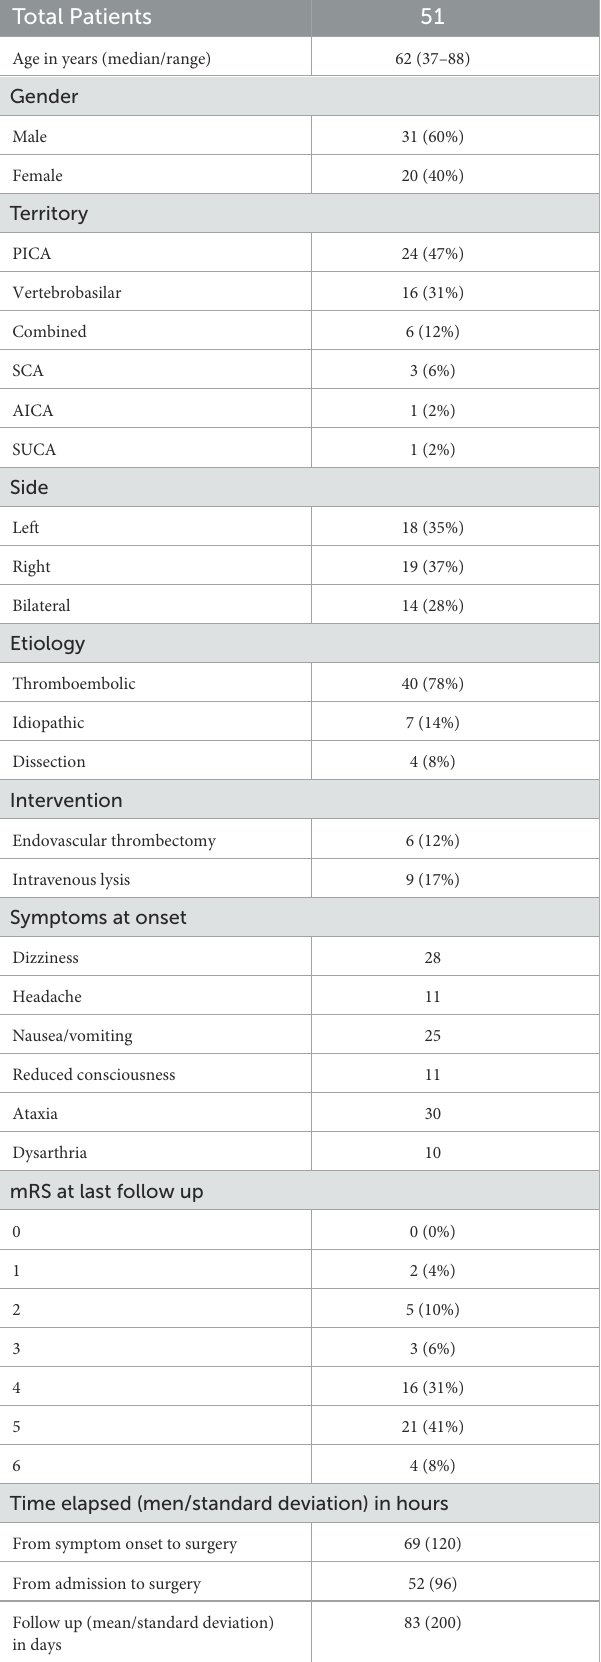
TABLE 2 GCS and radiological characteristics at admission and at the